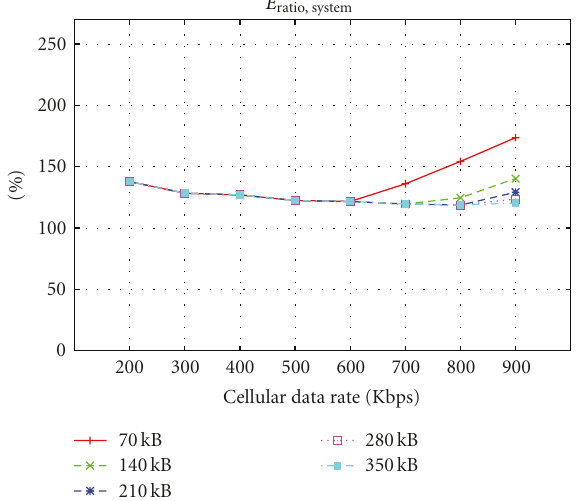
Figure 8: D ratio plotted against DR Cell for di ff erent sizes of D tot .